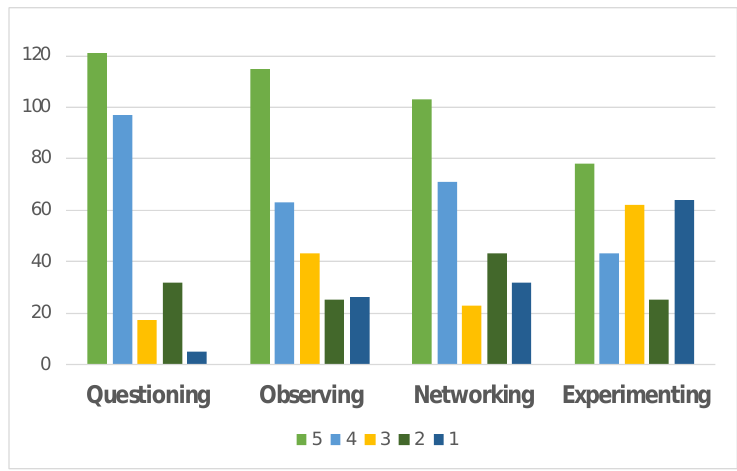
Fig. 3. Participants response using Likert